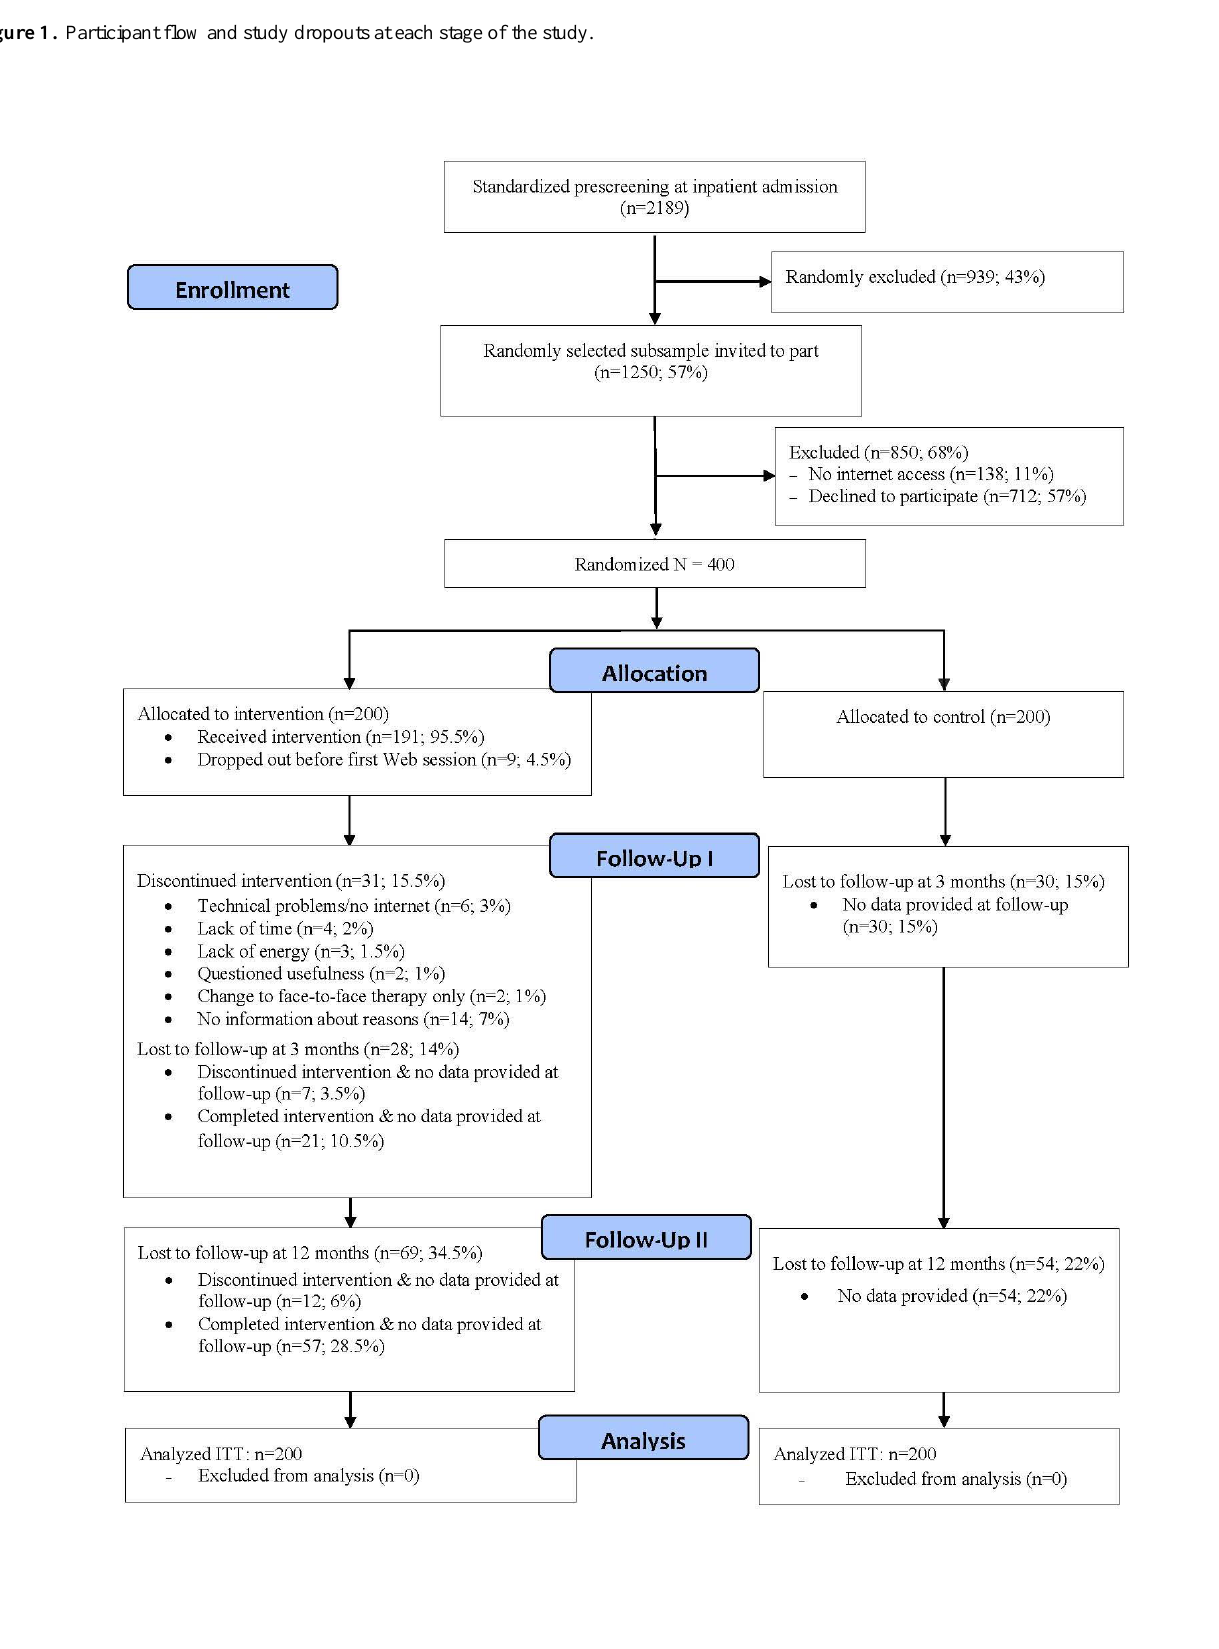
Figure 1. Participant flow and study dropouts at each stage of the